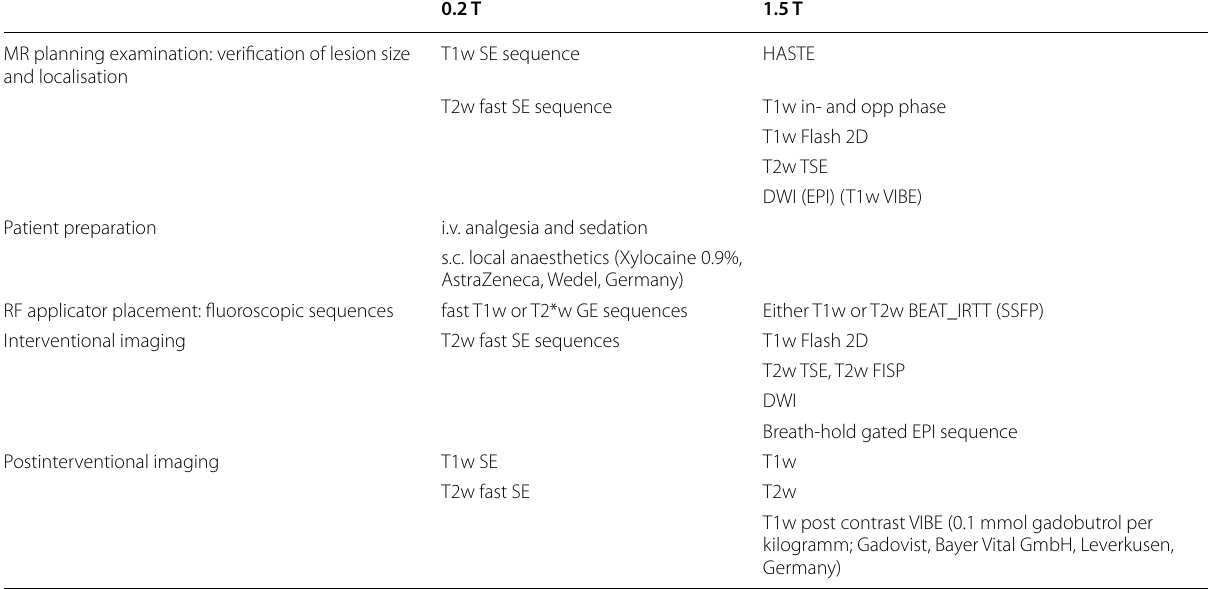
Table 1 Overview of the different applied MR sequences for RFA performed at 0.2 T and 1.5